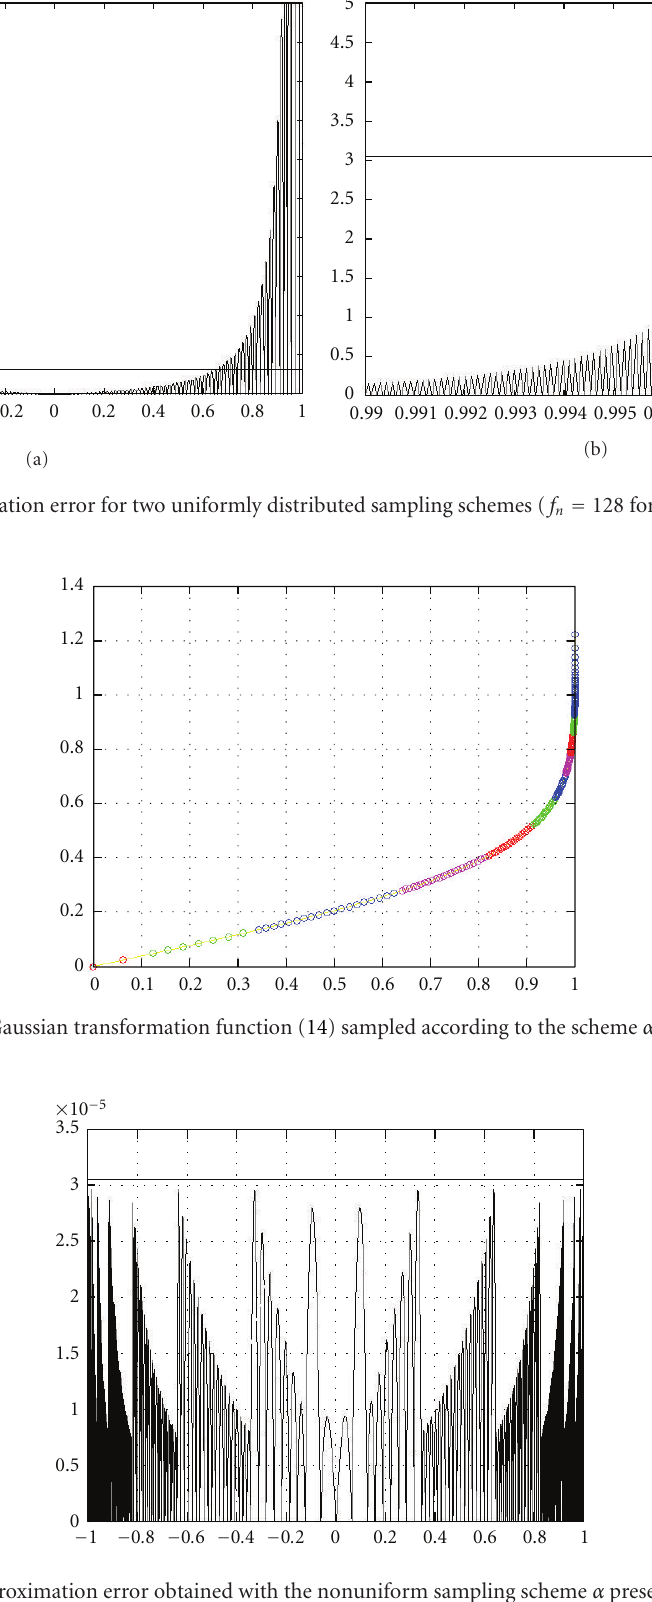
Figure 5: Absolute approximation error obtained with the nonuniform sampling scheme α presented in Tables 1 and